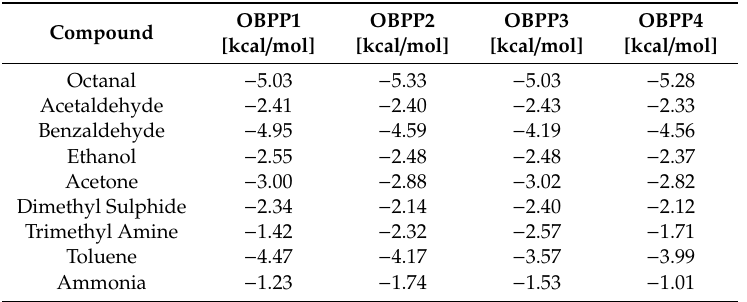
Table 1. The a ffi nity levels of peptide-based biosensors vs. volatile